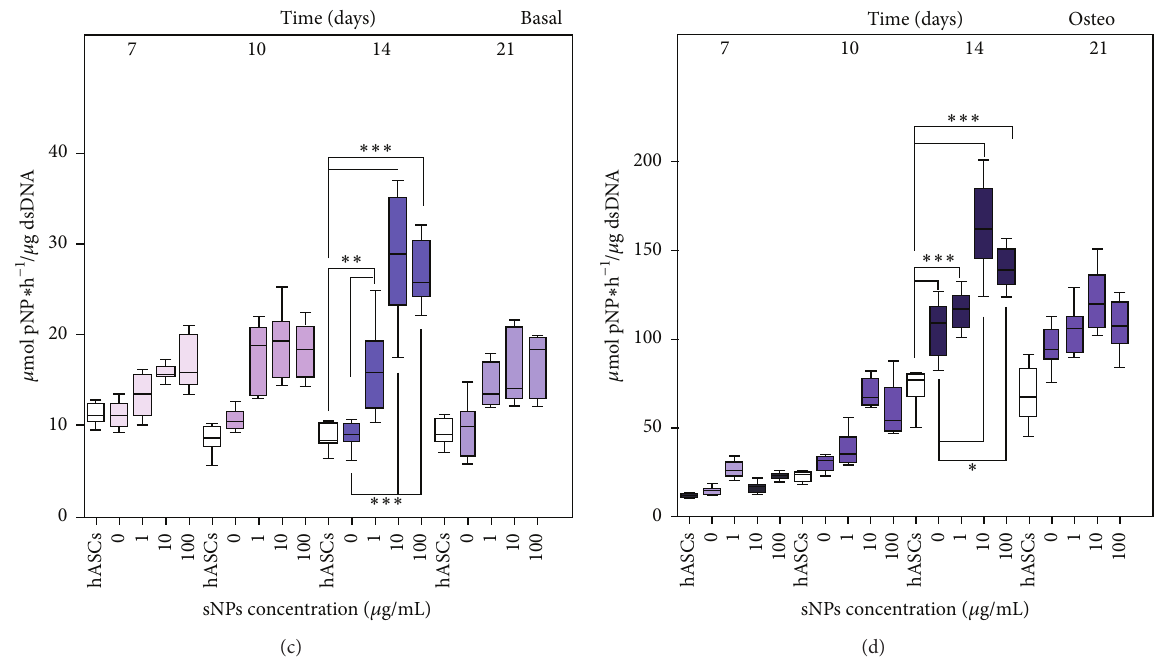
Figure 3: Culturing ASCs with bioactive silicate nanoplatelets promotes the osteogenic differentiation of ASCs. (a) Experimental procedures used to induce osteogenic differentiation. SSEA-4 + adipose-derived stem cells (ASCs). SSEA-4 + ASCs were seeded in basal medium for 1 day, and silicate nanoplatelets (sNPs) were added to the basal medium. The samples were incubated either in basal medium or under osteogenic differentiating conditions. Samples were collected on days 7, 14, 21, and 28 to analyze differentiation. (b) Qualitative analysis of alkaline phosphatase (ALP) in SSEA-4 + ASCs on days 7, 10, 14, and 21 cultured in basal and osteo media, compared to ASCs. The dark purple color increased with sNP concentration level and osteo medium presented a darker purple color. (c) Quantitative analysis of ALP in SSEA-4 + ASCs in basal medium with sNPs. The presence of sNPs enhanced ALP activity on day 14, compared to that in ASCs. (d) Quantitative analysis of ALP in SSEA-4 + ASCs in osteo medium with sNPs. The presence of sNPs enhanced ALP activity on day 14, compared to that in ASCs (adopted from [63]). ∗ 𝑝 < 0.05 , ∗∗ 𝑝 < 0.01 , and ∗∗∗ 𝑝 < 0.001